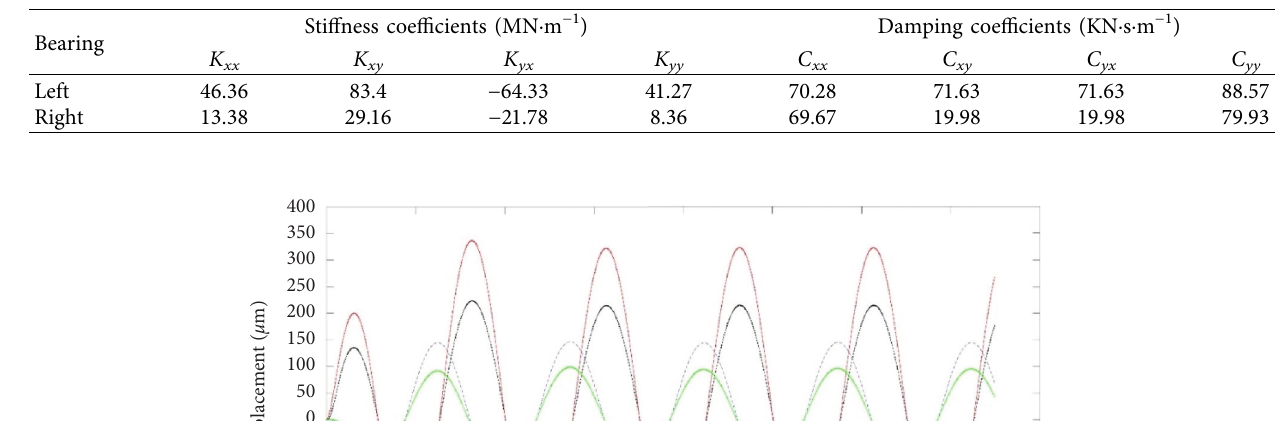
Table 1: Bearing dynamic parameters.